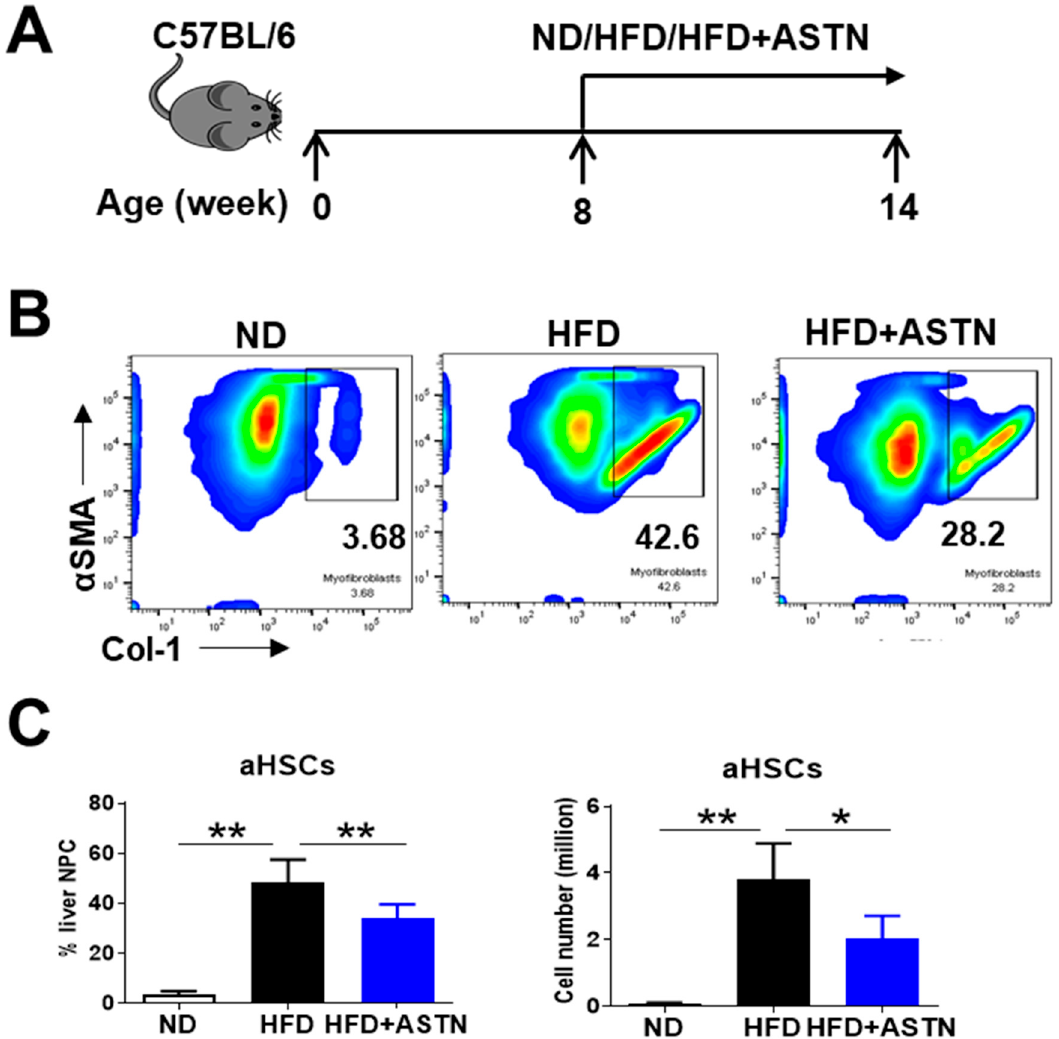
Figure 4. Astaxanthin treatment inhibits HFD-induced liver fibrosis. ( A ) An outline depicting ASTN treatment design. Eight-week-old WT C57BL/6 mice were fed with a HFD for 6 weeks with or without receiving simultaneous ASTN treatment. WT mice fed with ND were used for control. ( B ) Representative and ( C ) accumulated results from flow cytometric assay indicated that ASTN treatment caused the reduced frequency and cell number of activated HSCs expressing Col-1 and α -SMA in the livers of HFD-fed mice. n = 5, error bars represent the mean ± SD. Statistical analysis of data was performed by one-way ANOVA using GraphPad Prism 8 software. ** p < 0.01, * p < 0.05.